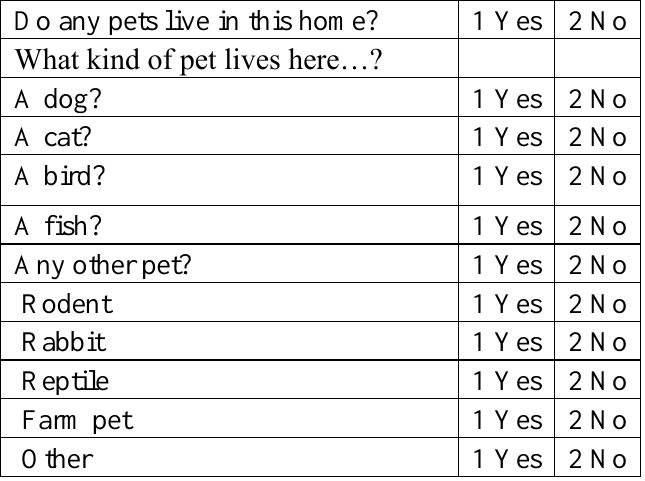
Table 1. Exposure variable questionnaire items.